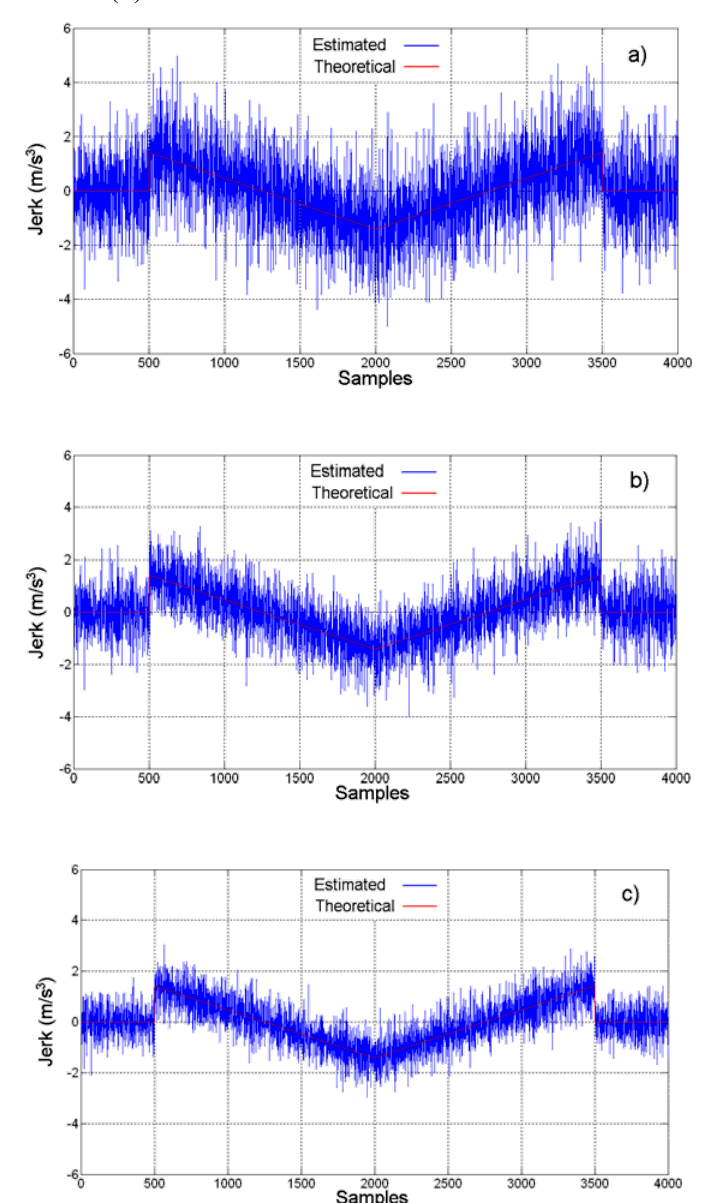
Figure 16. Jerk estimation with oversampling and averaging decimation. (a) 4-times. (b) 8-times. (c) 16-times. (d)